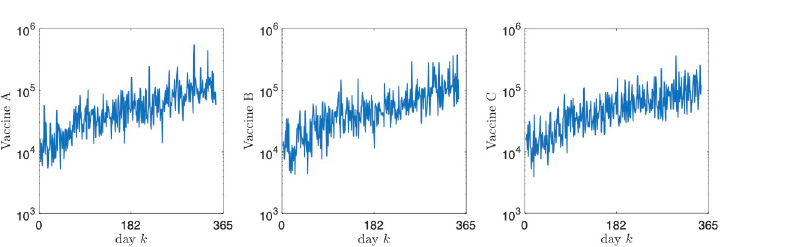
Fig 4. Intervention plan corresponding to the found solution in terms of the units of the different types administered for each day.